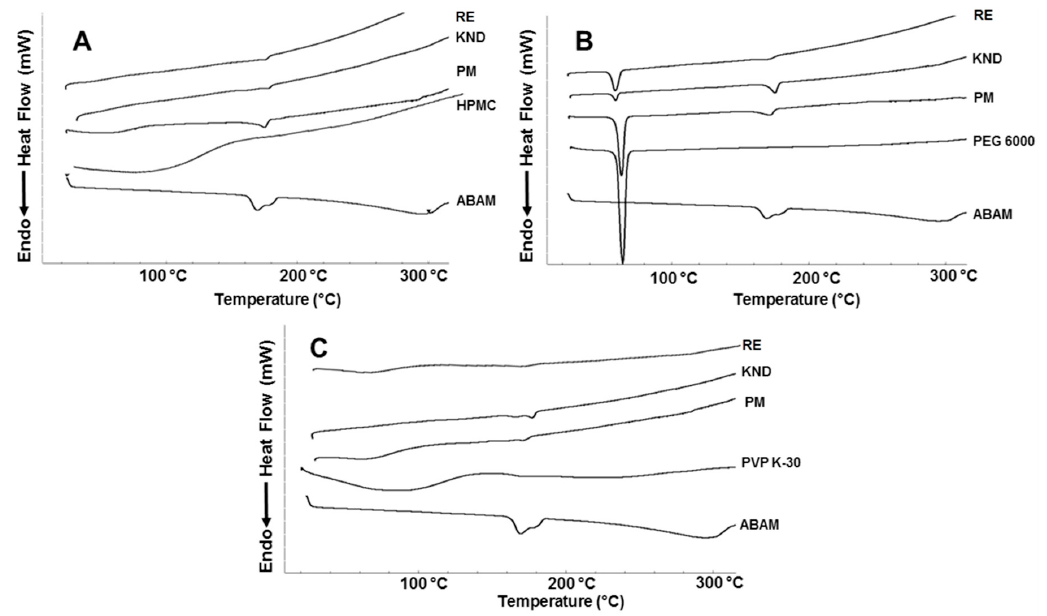
Figure 5. ( A ) DSC curves for ABAM and HPMC alone, as well as PM and SDs prepared by KND and RE; ( B ) DSC curves for ABAM and PEG 6000 alone, as well as PM and SDs prepared by KND and RE; ( C ) DSC curves for ABAM and PVP K-30 alone, as well as PM and SDs prepared by KND and RE.